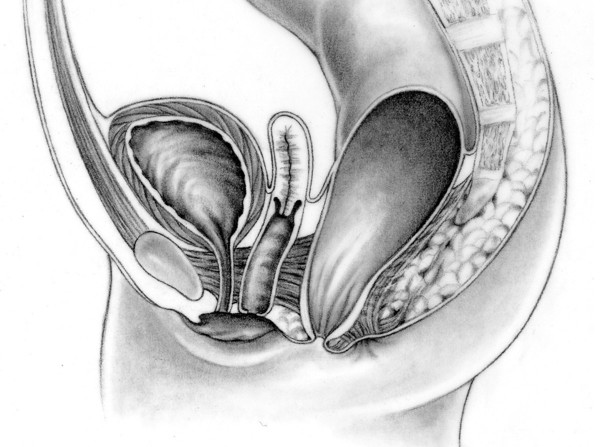
Perineal fistula.